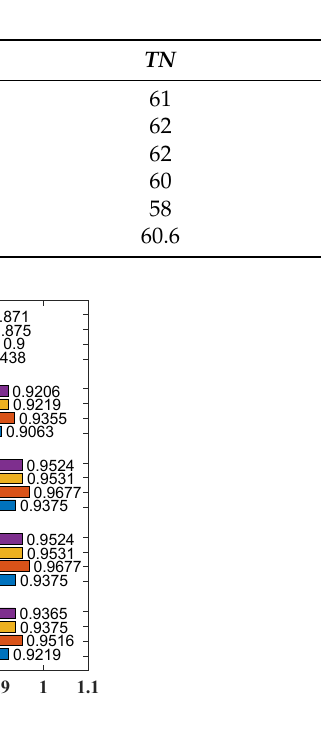
Table 1. Key factors for bathroom fall tests.